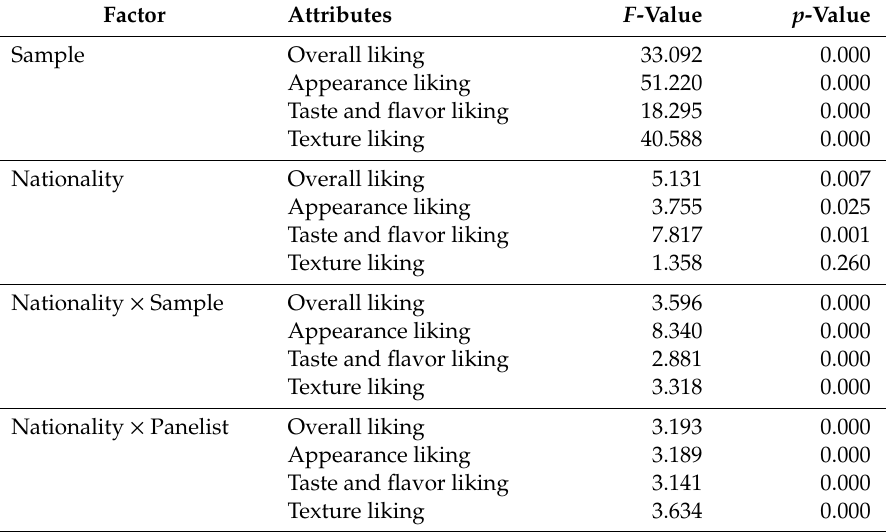
Table 3. F - and p - values associated with statistical significance for 13 types of dried